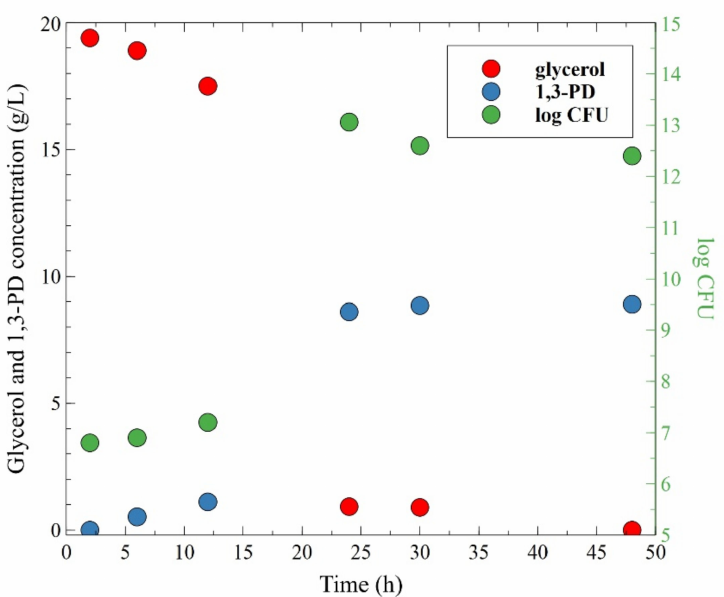
Figure 4. The changes of glycerol and 1,3-propanediol concentrations and number of viable cells bacteria in the broth during the fermentation process with pH regulation (broth pH = 7). Initial glycerol concentration: 20